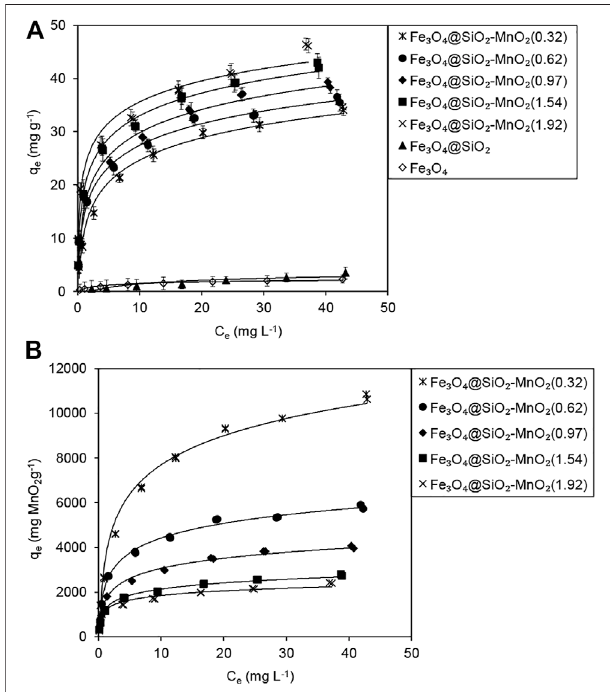
FIGURE 6 | (A) Pb(II) adsorption isotherms and (B) MnO 2 content- normalized Pb(II) adsorption isotherms of the samples. (Adsorbent dosage =